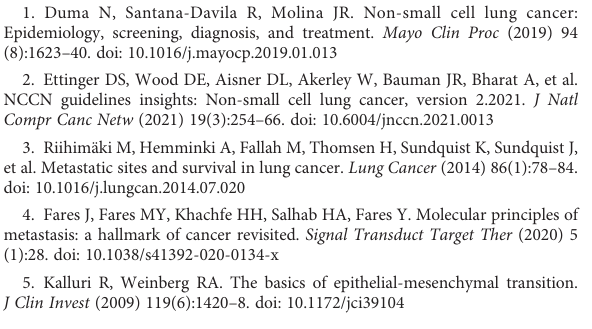
SUPPLEMENTARY FIGURE 8 Validation of the nomogram prognosis model in the TCGA validating and GEO cohorts. (A) Comparisonofsurvivalcurvesbetweenthehighandlow HMOX1 groups in the GSE11969, GSE31210, GSE42127, and GSE68465 cohorts. (B) Univariate Cox analysis screened the prognosis variables. (C) Multiple Cox analysis screened the prognosis variables. (D) Calibration plots showing the correlation between actual and predicted OS rates in the TCGA validating, GSE11969, GSE31210, and GSE42127 cohorts. (E) ROC curve plot evaluating the nomogram model in the TCGA, GSE11969, GSE31210, and GSE42127 validating cohort.